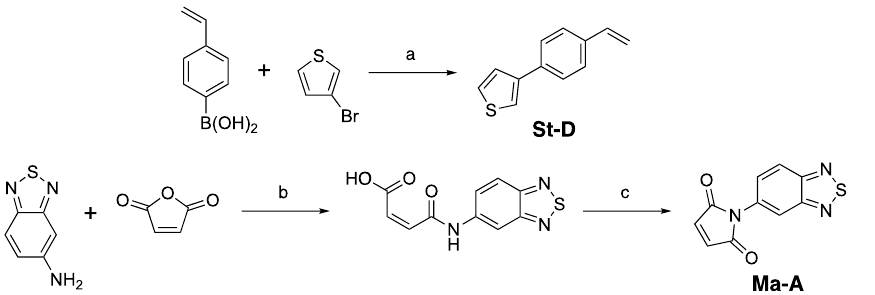
Table 1. Thickness, determined by ellipsometry, and water contact angles of organic layers on silica substrate during the formation of the initiator layer and subsequent RAFT polymerization leading to PB.